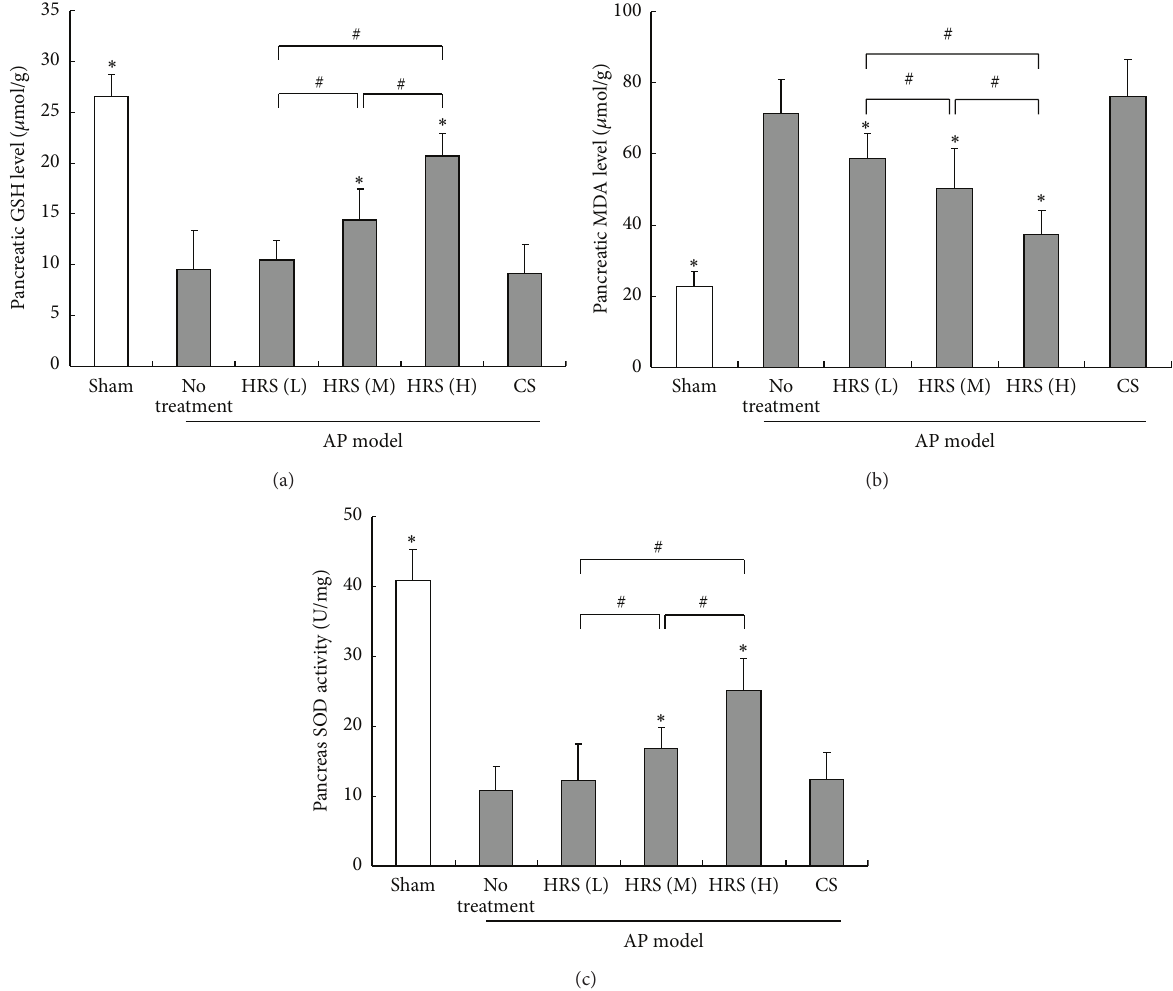
Figure 6: Determination of pancreatic tissue levels of GSH, MDA, and SOD in mice. The HRS at various doses or control saline (CS) was injected intraperitoneally to AP mice 1h after the final injection of cerulein, respectively. One hour later, animals in each group ( 𝑛 = 6 ) were killed and the pancreatic tissue samples were immediately collected and then homogenized on ice. After the measurement of protein concentration, the levels of GSH (a) and MDA (b) and the activity of SOD (c) in pancreatic homogenates were determined according to the methods reported previously. ∗ 𝑃 < 0.05 , compared with the group of AP mice with no treatment; # 𝑃 < 0.05 , compared in groups of AP mice treated with HRS at different doses; L: low dose (2mL/kg × 3); M: middle dose (4mL/kg × 3); H: high dose (8 mL/kg ×